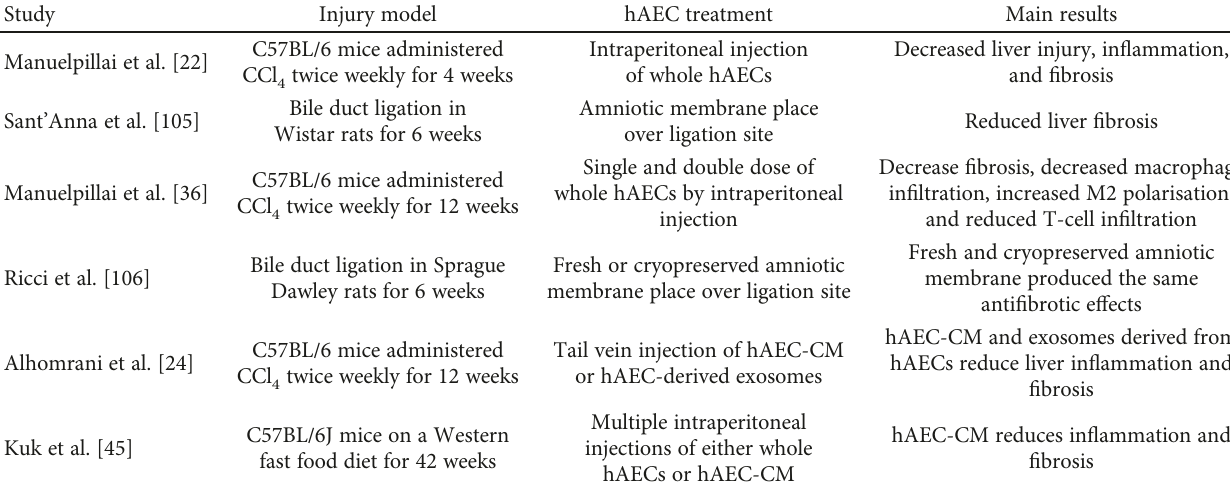
Table 1: Summary of results from studies using hAEC-based therapies in models of liver